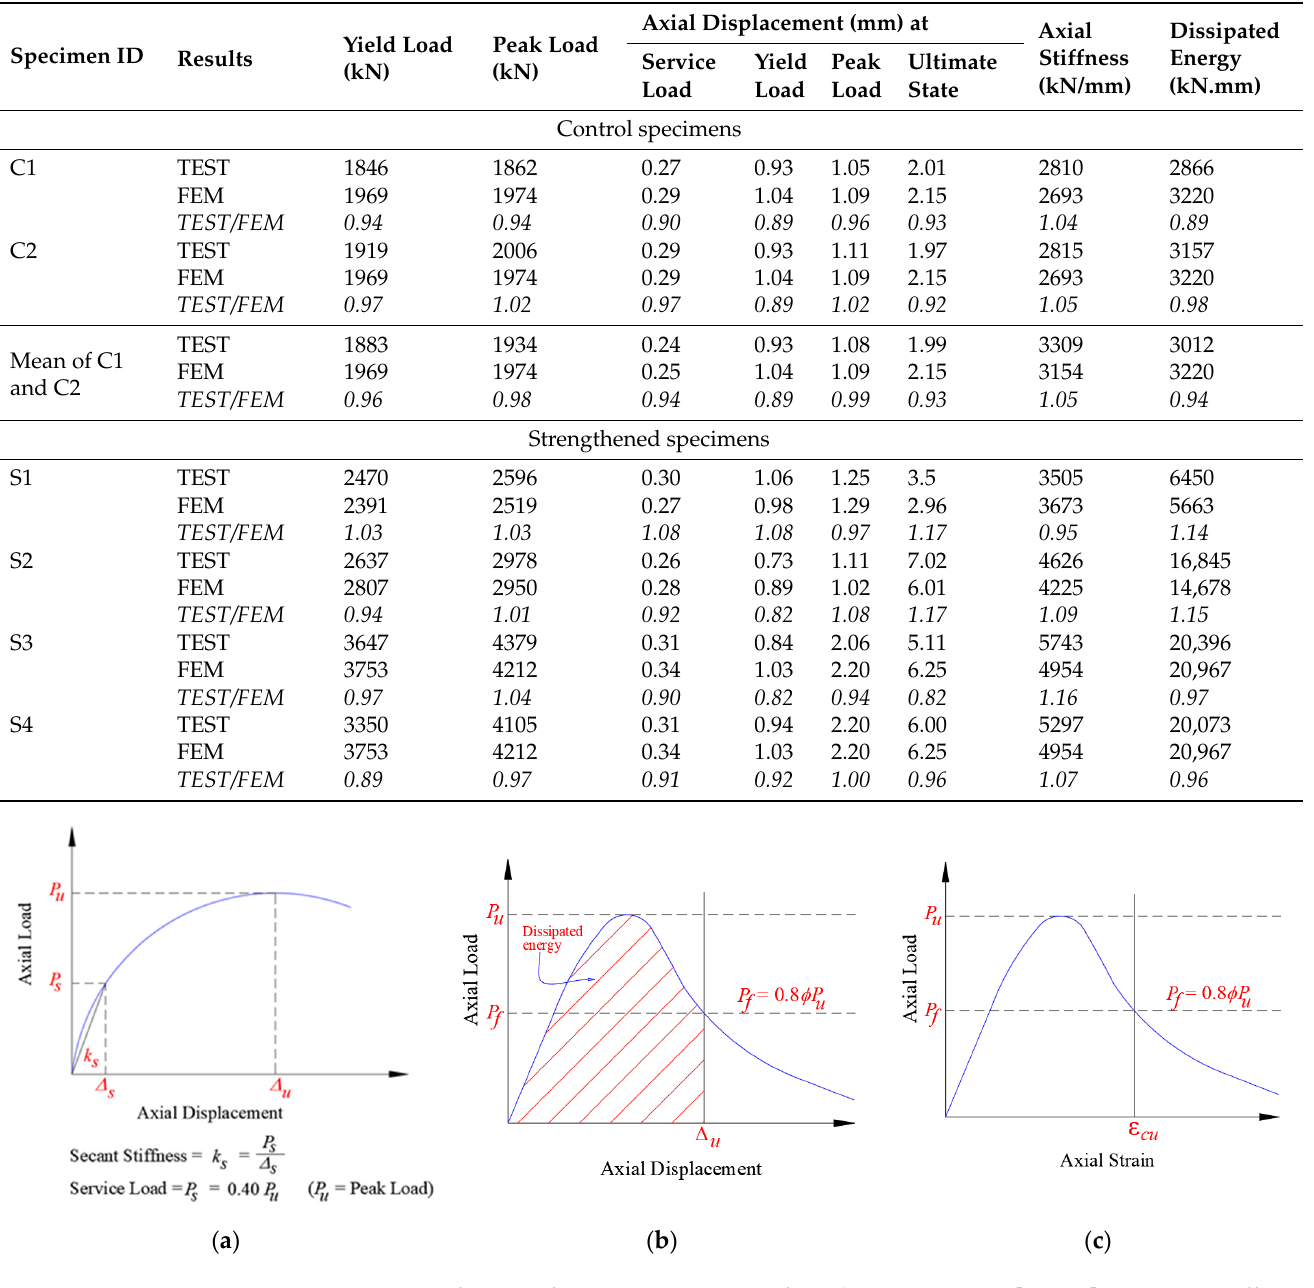
Figure 8. De fi nition of response parameters for column specimens [7,27,28]: ( a ) secant sti ff ness; ( b ) dissipated energy; ( c ) ultimate concrete strain. Table 3. Key results of load versus displacement characteristics for tested